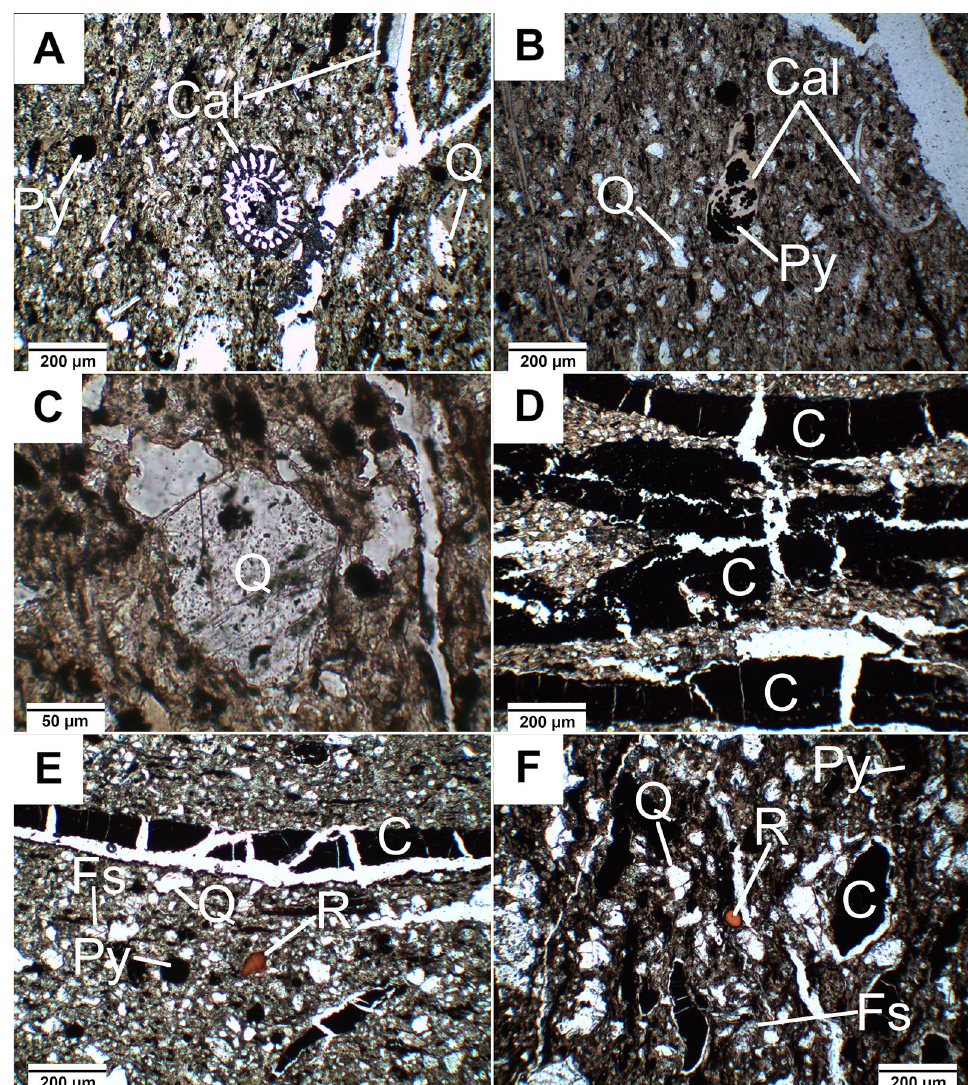
Figure 4. Microphotographs of the studied rocks. ( A ) Quartz (Q) and opaque minerals (mainly pyrite—Py) with a carbonate fragment of a coral and shells (Cal) in the matrix (SC1 sample, NX); ( B ) grain components of the rock with partially pyritized (Py) shell fragments (SC1 sample, 1N); ( C ) quartz grains with an euhedral shape (SC1 sample, 1N); ( D ) cracked coal laminae in the matrix (SC3 sample, NX); ( E ) quartz (Q), feldspars (Fs), opaque minerals (mainly pyrite—Py), cracked coal laminae and lenses (C) with fossil resin crumb (R) (SC3 sample, NX); ( F ) quartz (Q), feldspars (Fs), opaque minerals (mainly pyrite—Py), cracked coal lenses (C) with fossil resin crumb (R) in the rock matrix (SC4 sample,